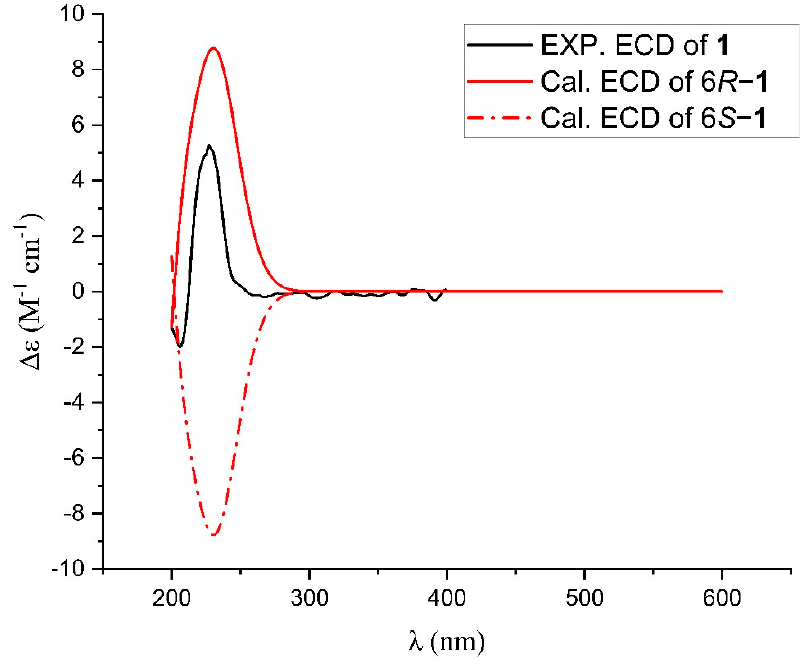
Figure 4. Experimental and calculated ECD spectra for 1 . Compound 2 was obtained as a yellowish oil with the molecular formula of C 10 H 14 O 5 based on the HREISMS data at m / z 237.0741 [M + Na] + (Figure S10), corresponding to four degrees of unsaturation. The IR spectrum of 2 (Figure S11) showed the existence of C=O (1735 cm − 1 ) and -OH (3418 cm − 1 ).The 1 H NMR (Table 1 and Figure S12) of 2 confirmed two methyl groups [ δ H 2.24 (3H, s), δ H 2.04 (3H, s)], one methylene [ δ H 3.92 (1H, dd, J = 10.8, 6.6 Hz) and 4.10 (1H, dd, J = 11.4, 3.6 Hz)], and four methines [ δ H 6.05 (1H, s), 7.31 (1H, s), 4.51 (1H, d, J = 6.0 Hz), 3.86 (1H, m)]. The 13 C NMR (Table 1 and Figure S13) analysis displayed 10 carbon signals in total at δ C 13.4, 20.7, 68.6, 66.9, 73.8, 106.1, 127.8, 139.6, 153.9, and 172.9. A comparison of the above 1D NMR data of 2 with those of 2-methyl-4-(1-glyc- eryl)-furan ( 3 ) revealed that the structures were similar, except for the presence of an ace- tyl group in 2 at C-8, which was consistent with the molecular formula and further con- firmed by key 1 H- 1 H COSY,HSQC and HMBC correlations (Figure 3, Figure S14, Figure S15 and Figure S16). Both 2 and co-purified 2-methyl-4-(1-glyceryl)-furan ( 3 ) had positive specific rotation and shared similar biosynthetic origins; supporting the absolute config- uration of 2 were 6 R and 7 R , in accordance with 3 . Thus, the structure of 2 was determined as shown and named as Nicardifuran E. Compound 3 was obtained as a colourless amorphous solid with the molecular for- mula C 8 H 12 O 4 as deduced by HRESIMS ( m/z 195.0628 ([M+Na] + and Figure S17). The 1D NMR data analyses (Table 1, Figure S18 and Figure S19), combined with a specific rotation